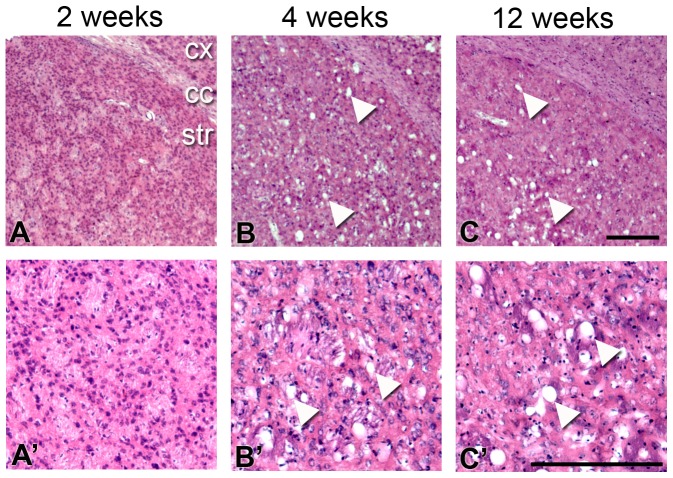
Early postnatal development of spongiform vacuolation in PGC-1α −/− striatum.Hematoxylin and eosin (H&E) stained coronal sections from PGC-1α −/− mice at two, four, and twelve weeks demonstrate the appearance of vacuoles between two weeks (A; no vacuoles present) and four weeks (B; arrowheads) of age. Notably, vacuoles do not appear to increase in size or number between four weeks and twelve weeks (C) of age, indicating that neurodegeneration does not progress as animals transition from the early postnatal period to adulthood. No vacuoles were observed in age-matched PGC-1α +/+ littermates (data not shown). A′–C′ are higher power images from the sections in A–C. Cx, cortex. Cc, corpus callosum. Str, striatum. Scale bars = 250 µm.